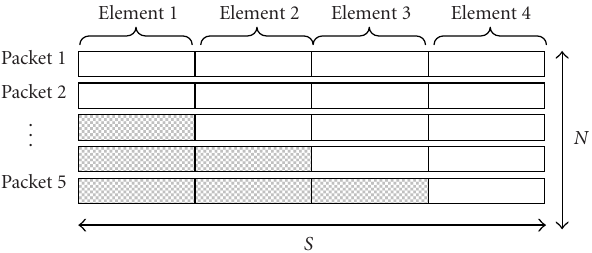
Figure 1: An example of PET arrangement of source elements into packets. Four elements are arranged into N = 5 packets with size S bytes. Elements (cid:1) (cid:1) k = { 2,3,4,5 } , respec- 1 to 4 are assigned tively. The white areas correspond to the elements’ content while the shaded areas contain parity